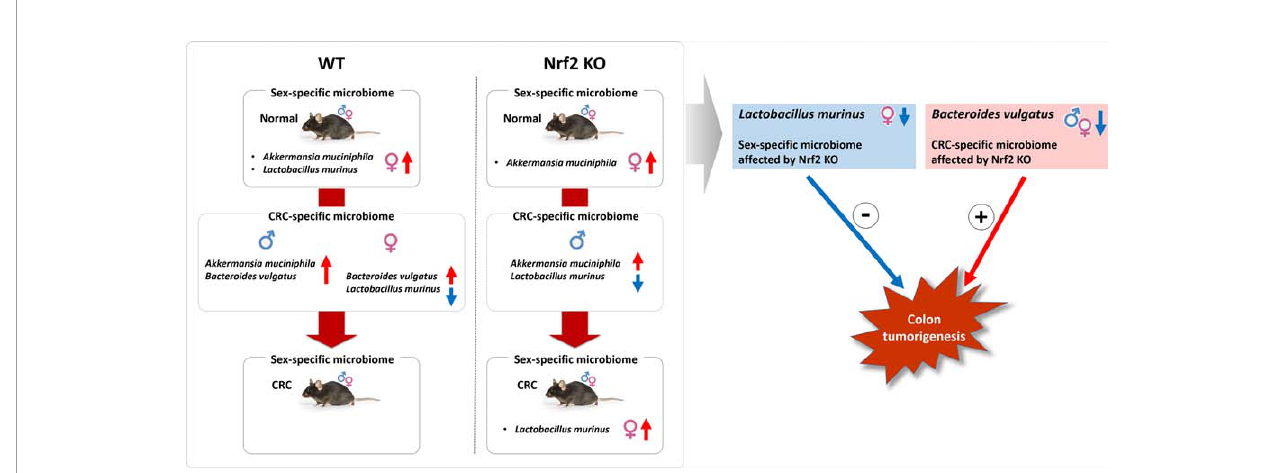
FIGURE 10 | Illustrative summary. The fi ndings of this study indicated that Nrf2 KO was associated with sex-speci fi c and CRC-speci fi c alterations in the gut microbiome composition in the mouse model. Nrf2 KO differentially altered the abundance of two bacterial species, which are L. murinus and B . vulgatus , depending on sex and CRC induction. Interestingly, the sex-speci fi c difference in the abundance of L. murinus , which was modulated by Nrf2 KO, was negatively correlated with the colitis-associated CRC index. In contrast, the CRC-speci fi c difference in the abundance of B . vulgatus , which was also regulated by Nrf2 KO, was positively correlated with colitis-associated CRC indices. WT, wild-type; KO, knockout; CRC, colorectal cancer; +, positive correlation; -, negative